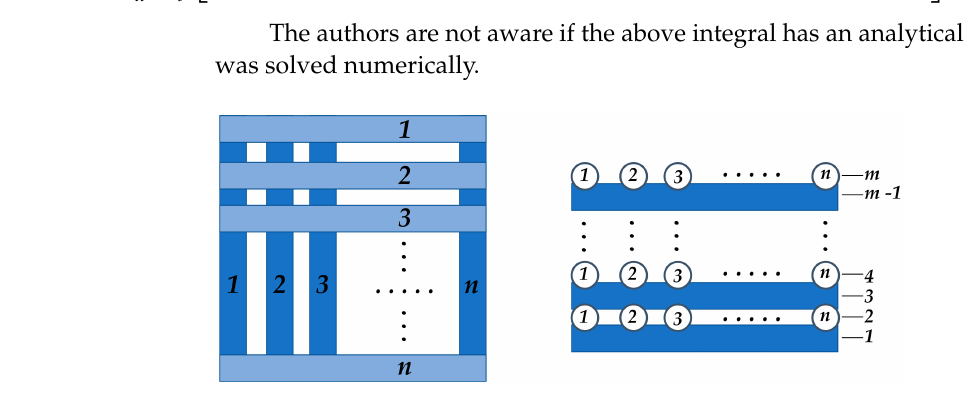
Figure A2. Schematic view of a n × n × m grid of